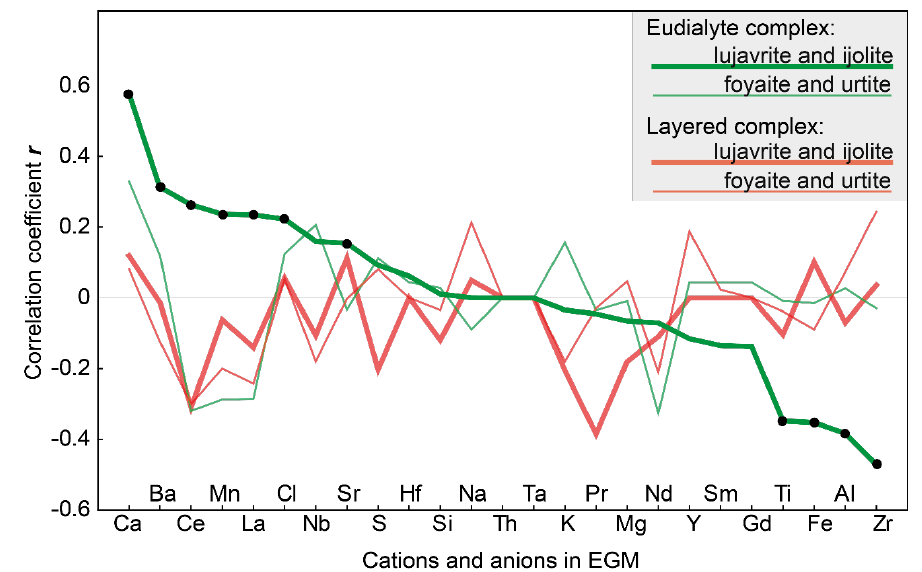
Figure 11. Correlation coefficient (r) between the contents of Mg in clinopyroxene and elements in coexisting eudialyte-group minerals. Black dots indicate significant (p ≤ 0.05) correlation coefficients. The cations and anions in the EGM are placed in accordance with a decrease in the correlation coefficient between the composition of EGM and the Mg Px from lujavrite and ijolite of the Eudialyte complex.